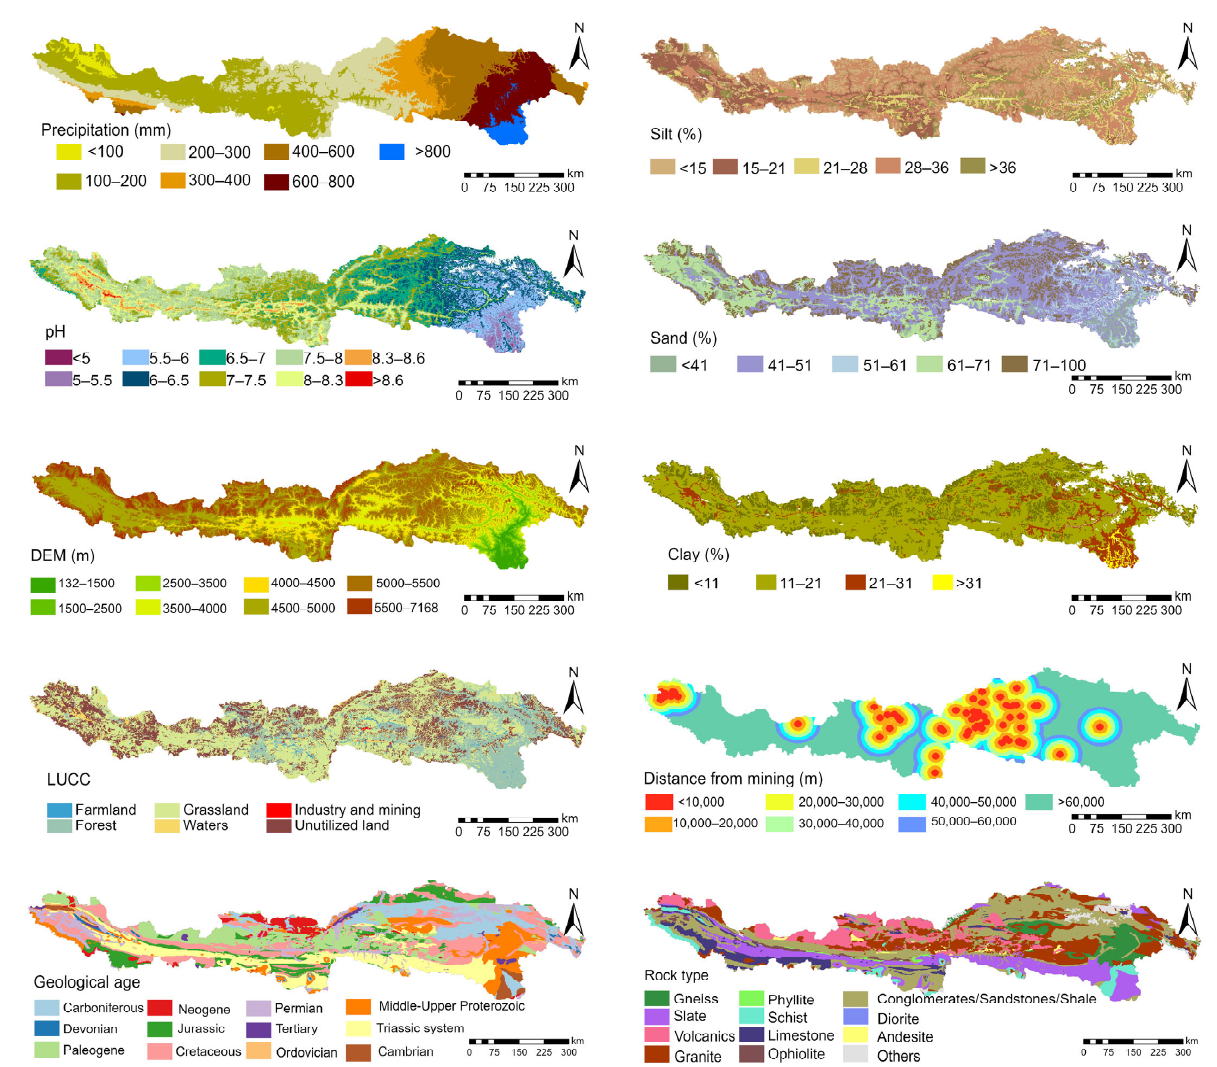
Figure 3. Stratification of the 10 influencing factors